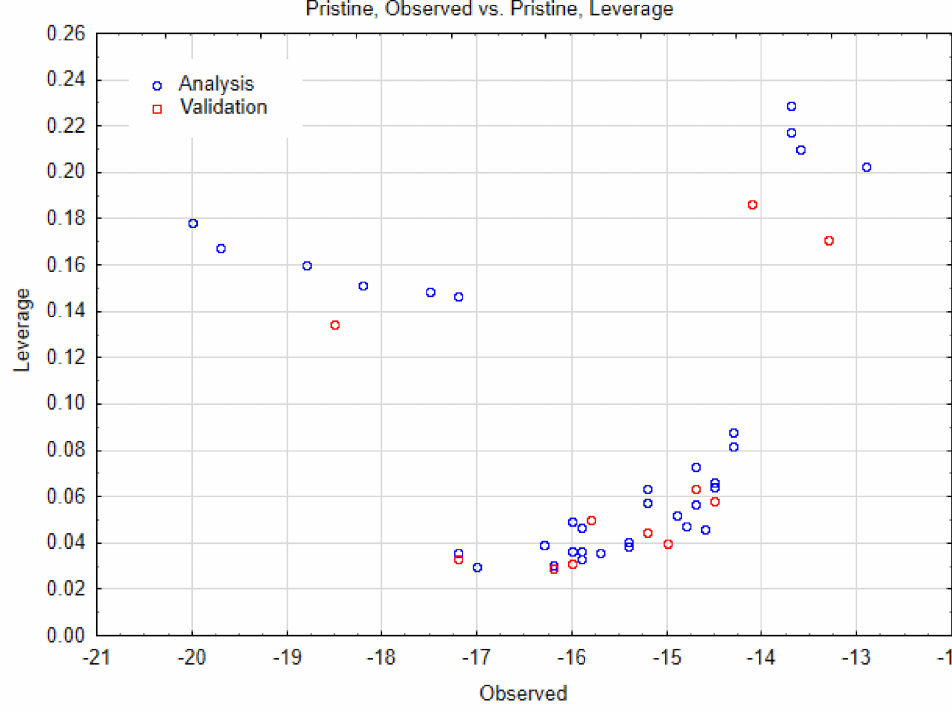
Figure 7. Applicability domain for SWCNT-pristine